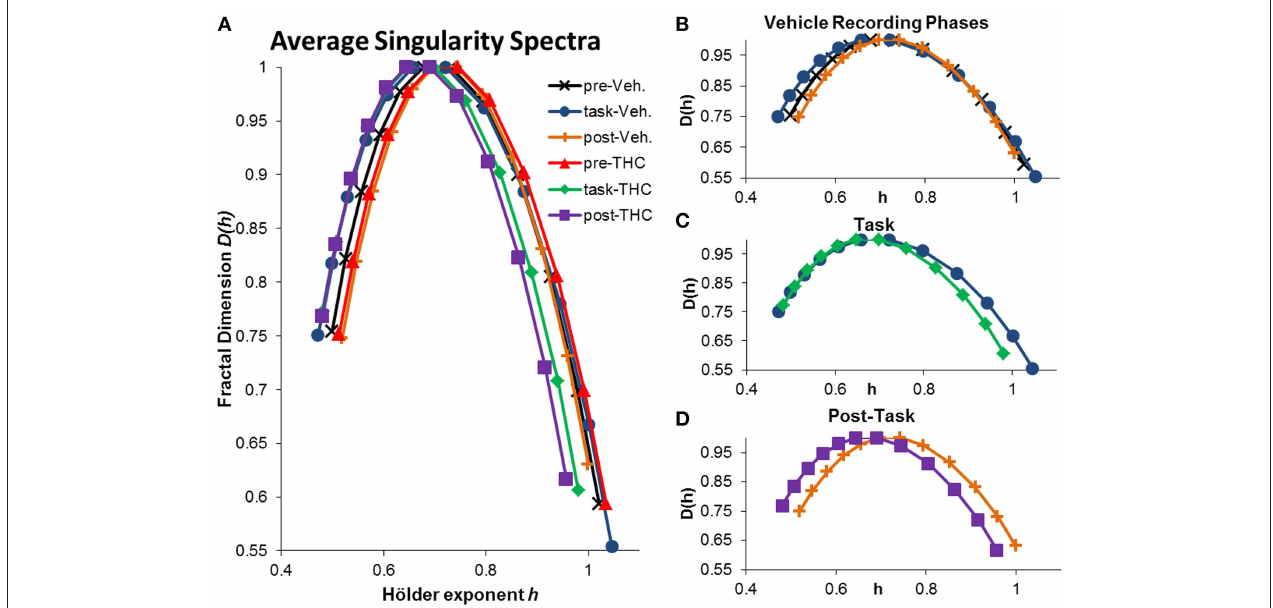
FIGURE 5 | Average singularity spectra across recording phases and drug conditions. Average spectra were computed by averaging all neurons within the respective recording phase and drug condition. A total of 197 hippocampal neurons were recorded from 10 different rats. Each neuron was recorded from the same electrode over multiple days and multifractal analysis was performed on a total of 5143 individual ISI sequences. 771–1004 individual ISI sequences were averaged for each condition. The legend in the upper right corner of (A) holds true for all figures. (A) Average singularity spectra were obtained from all neurons recorded during their respective recording phase and drug condition. (B) Average singularity spectra from all recording phases during vehicle treatment are plotted for comparison. Neurons exhibit greater multifractal complexity (i.e., wider singularity spectra; wider range of Hölder exponents h ) during the task compared to either resting state. Long-range temporal correlations, indicated by the Hurst exponent, which is closely related to the Hölder exponent at the apex of the singularity spectrum [where D ( h ) = 1 ], are stronger during the resting states compared to the task. (C) Average singularity spectra from both drug conditions during DNMS task recordings show that THC reduces multifractal complexity, as indicated by decreased singularity spectra width. (D) Average singularity spectra taken from post-task recording phases show that THC reduces LRTCs (i.e., decreased Hurst exponent) compared to vehicle recordings; this effect is seen as the leftward shift in the THC spectrum comapred to the vehicle one. Multifractal complexity was unchanged by THC during post-task